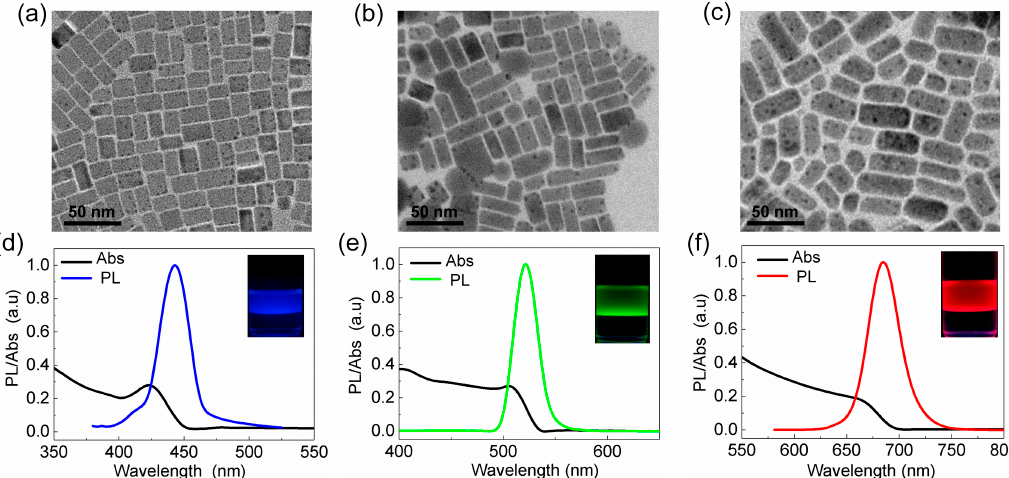
Figure 2. TEM images of samples prepared by Cs 4 PbBr 6 n-hexane dispersion reaction with 0.5 mmol/mL KX (X = Cl, Br, I) aqueous solution: ( a ) KCl aqueous solution, ( b ) KBr aqueous solution, ( c ) KI